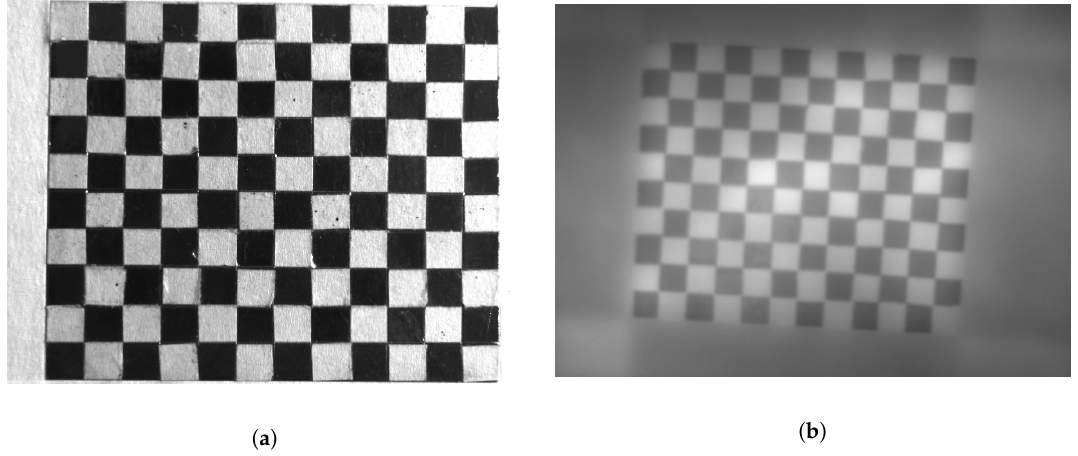
Figure 3. Calibration Pattern (( a ) Calibration pattern in the VIS spectrum, ( b ) Calibration pattern in the LWIR